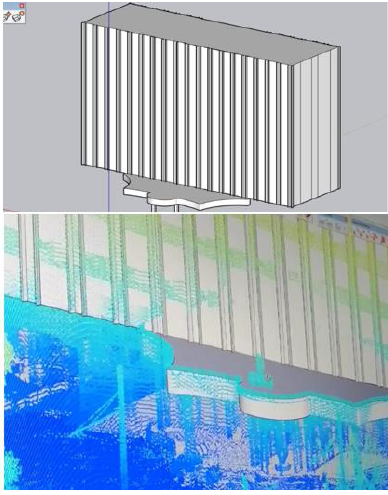
Figure 13. Modeling process.